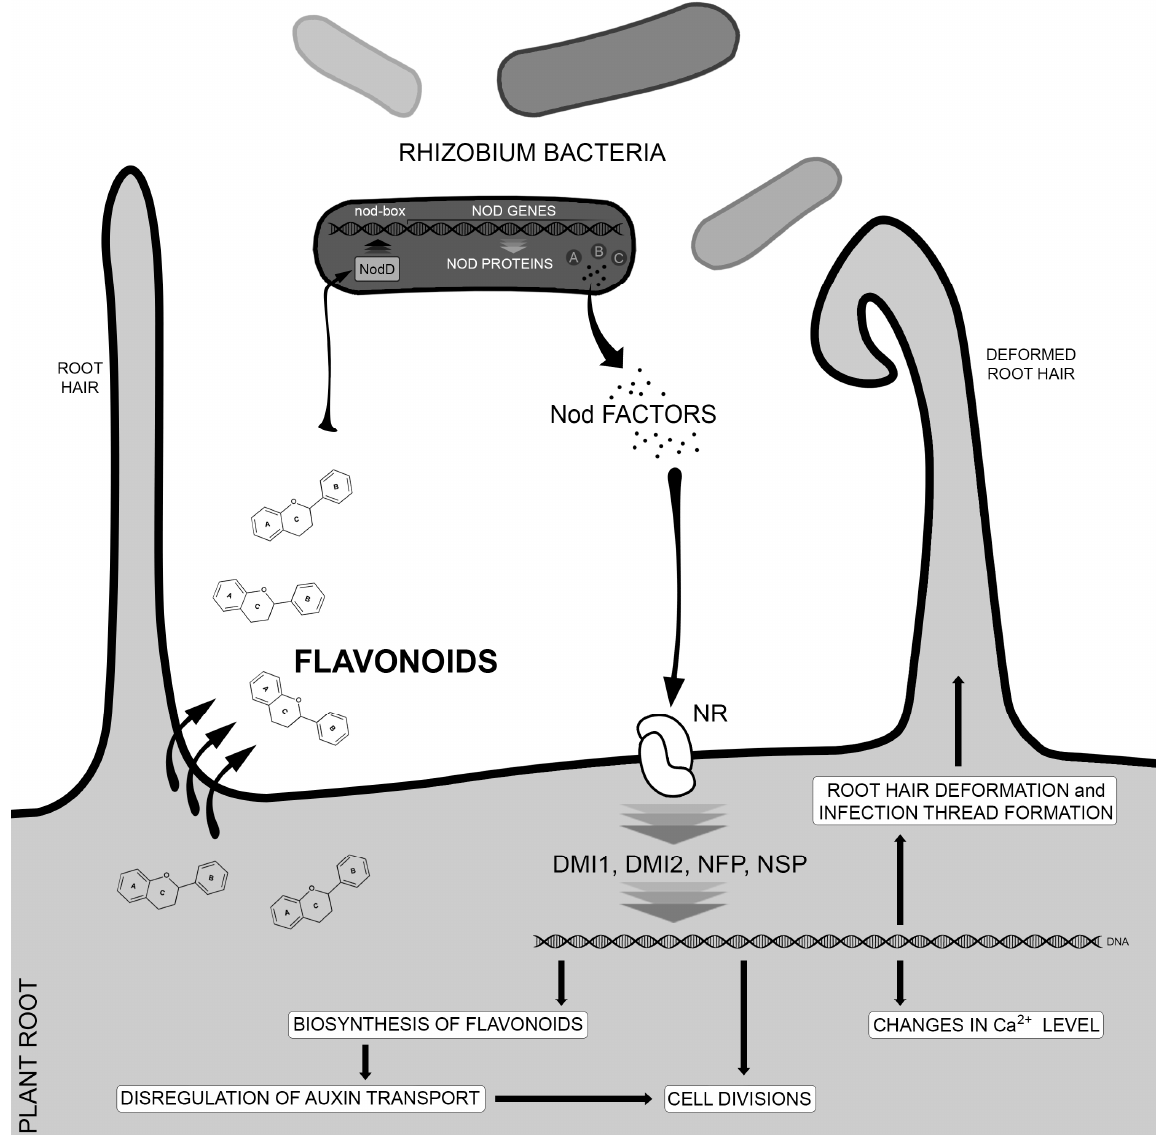
Figure 2. The role of flavonoids in the interactions between nitrogen-fixing bacteria and legume plants. Flavonoids are released by the plant bind to and activate NodD protein, which, in turn, attaches to no-box cassettes in the promoter sequences of nod genes, leading to the production of nod proteins and subsequently nod factors. These molecules bind to the nod factor receptors (NR) localized on the plant cell membrane, starting a cascade of signal transduction. This signal activates various gene expression, leading to root hair deformation, formation of infection thread, flavonoid biosynthesis, cell division and, finally, root nodule